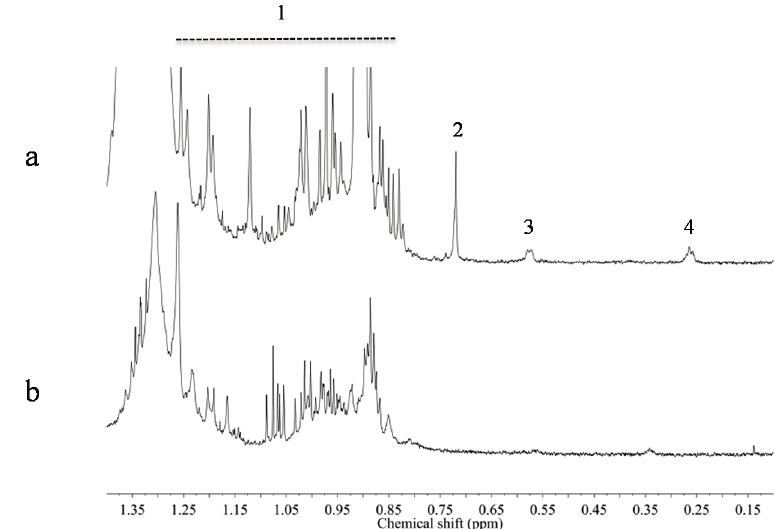
Figure 2. 1 H-NMR spectra of Astragalus membranaceus roots collected in Shanxi province in China (No. of voucher specimen: 20131206-2). ( a ) In CD 3 OD; ( b ) CD 3 OD-KH 2 PO 4 buffer in D 2 O (1:1, v/v), 1: methyl signals of astragaloside I, II, III, IV, isoleucine, leucine, and valine, 2: H-24 of astragaloside VIII and soyasaponin I, 3: H-19a of astragalosides, 4: H-19b of